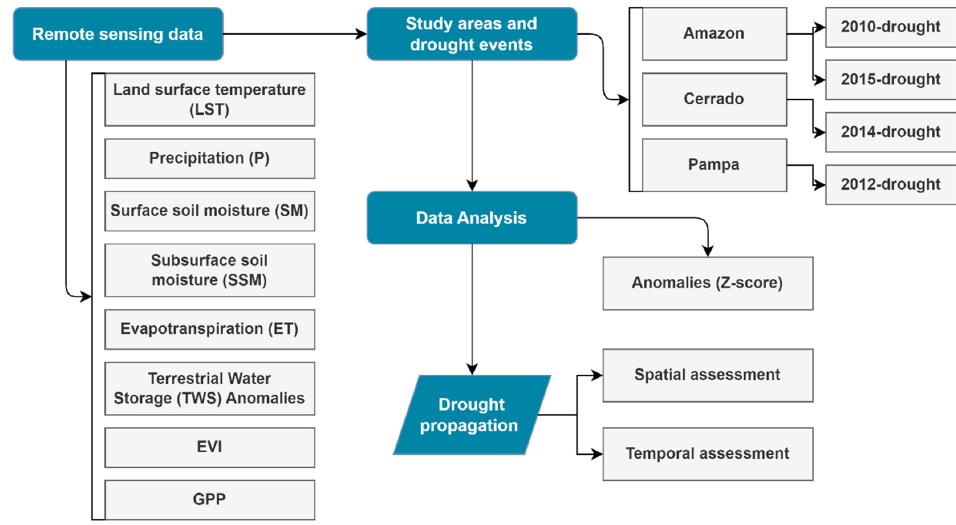
Figure 2. Methodological flowchart applied in this study.